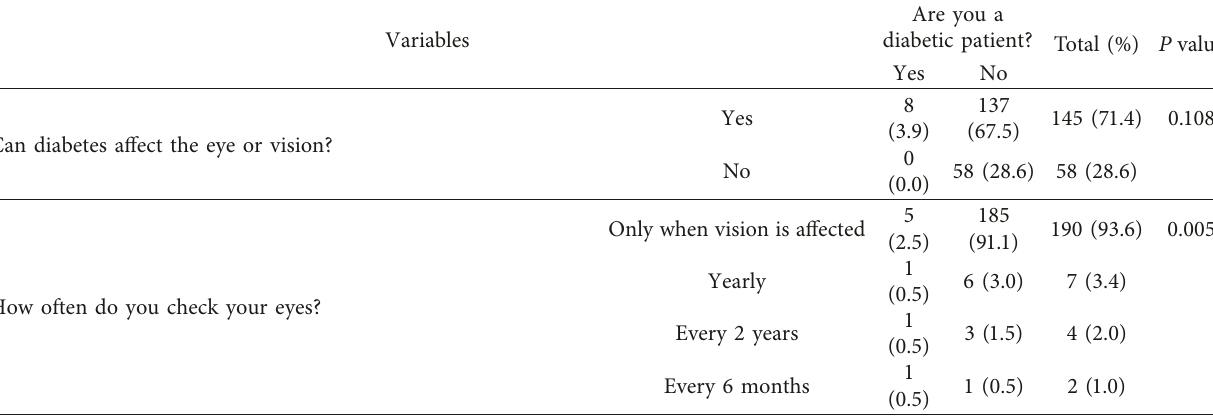
Table 4: Association between the diabetic status of patients and their knowledge and awareness of DM and